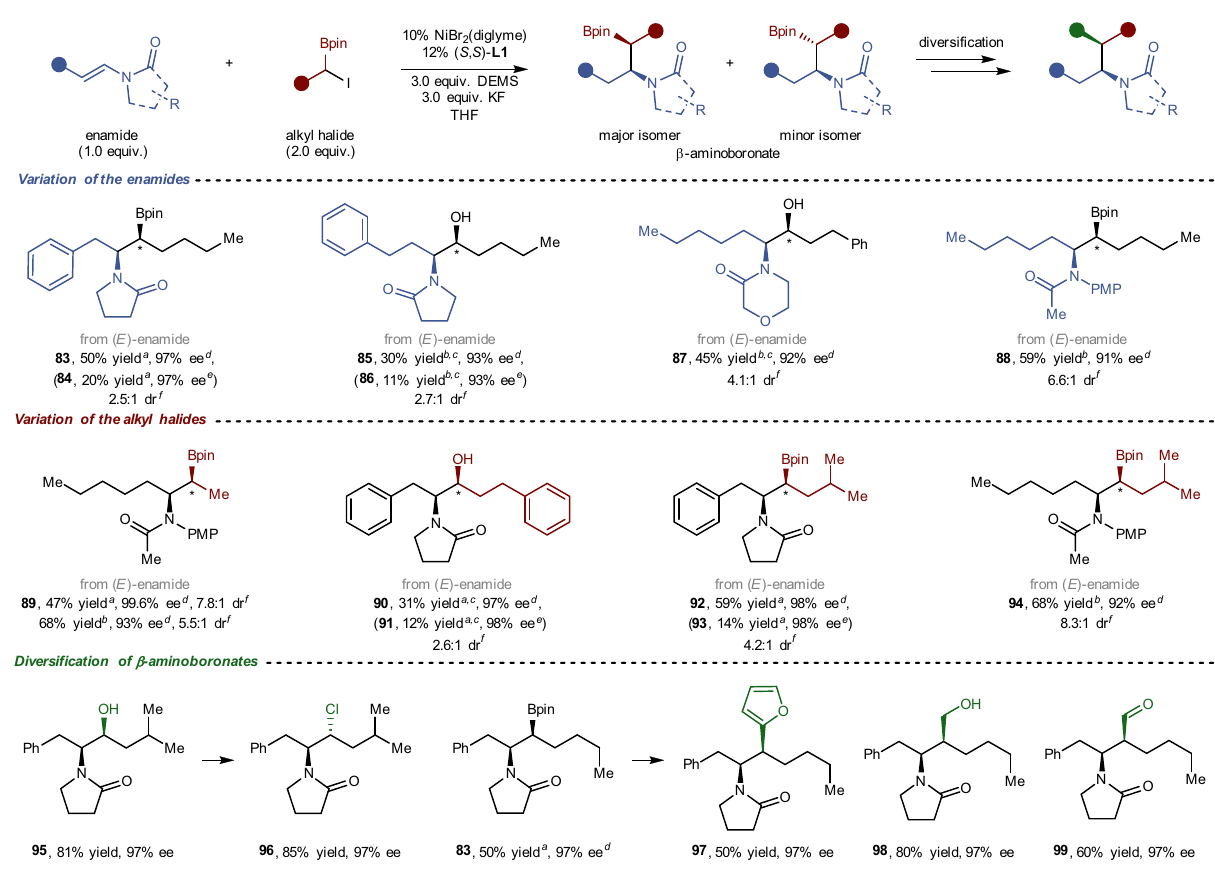
Fig. 5 Asymmetric reductive hydroalkylation of enamides with racemic α -haloboronates to access β -aminoboronates. a 25 °C, 24 h, isolated yield, 0.20 mmol scale. b 40 °C, 24 h, isolated yield, 0.20 mmol scale. c The product was isolated after the oxidisation of the corresponding alkylborate. d enantiomeric excess of major isomer after oxidisation. e enantiomeric excess of minor isomer after oxidisation. f The dr value was determined via 1 H NMR analysis of crude β -aminoboronates or HPLC analysis of crude β -aminoalcohols. g Diastereocenters marked with an asterisk symbol. Bpin = boronic acid pinacol